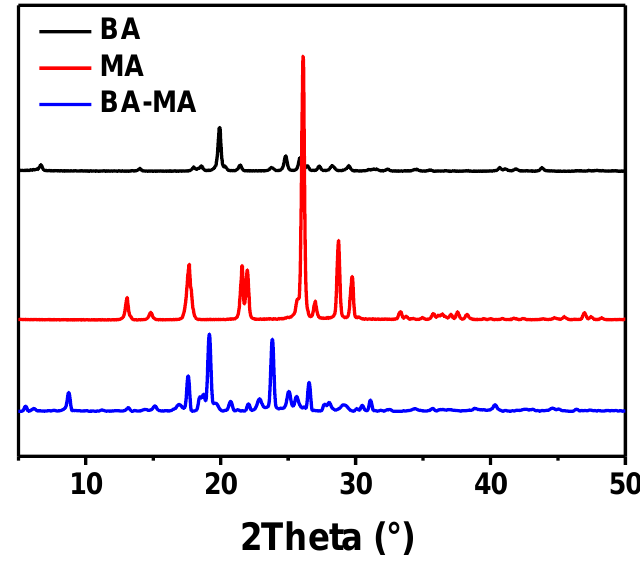
Figure 3. XRD patterns of BA, MA, and BA-MA.